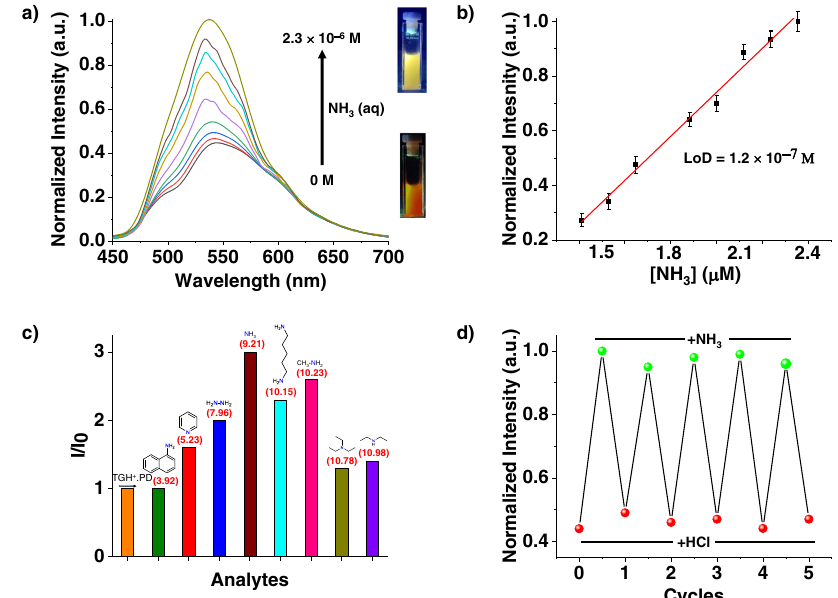
Fig. 3 Amine responsive behavior of fl uorescent TGH + (cid:129) PD COF. a Change in the emission of an aqueous dispersion of TGH + (cid:129) PD ( λ ex = 365 nm) with increasing amounts of NH 3 (aq), inset: photographs of an aqueous dispersion of TGH + (cid:129) PD under UV lamp irradiation showing the changes in fl uorescence after the addition of NH 3 (aq). b Linear fi t to the plot of emission against the concentration of NH 3 (0 – 2.3 × 10 − 6 M) added to an aqueous dispersion of TGH + (cid:129) PD to calculate the limit of detection (LoD) for NH 3 , the error bars represent the s.d. of triplicate measurements. c Bar diagram representing the relative fl uorescence intensity of TGH + (cid:129) PD in the presence of various amines, where I o is the intensity of initial TGH + (cid:129) PD, and I is the fi nal intensity in response to the analyte (the numbers in parentheses indicate the corresponding p K a value). d Reversible change in fl uorescence intensity of TGH + (cid:129) PD upon an alternate addition of NH 3 and HCl in water ( λ ex = 365